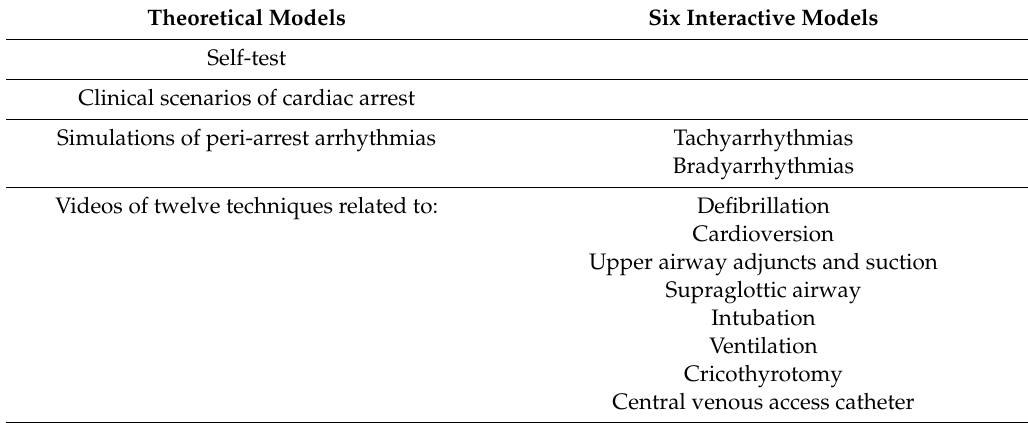
Table 2. Teaching materials included in ALS e-learning.